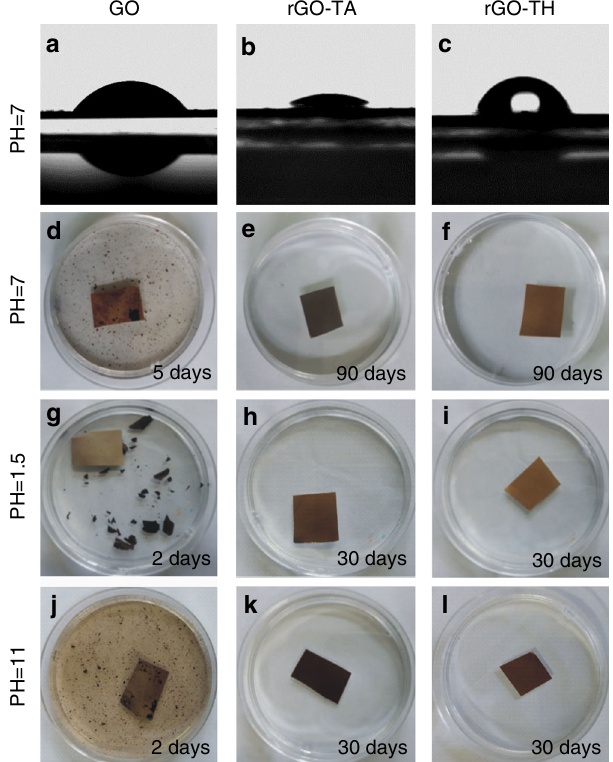
Fig. 2 Hydrophilicity and stability of GO-based membranes. a – c Photos of a water droplet on GO ( a ), rGO – TA ( b ), and rGO – TH ( c ) membrane surface. d – l Stability in water ( d – f ), acidic solution ( g – i ), and basic solution ( j – l ). d, g, j GO membrane. e, h, k rGO – TA membrane. f, i, l rGO – TH